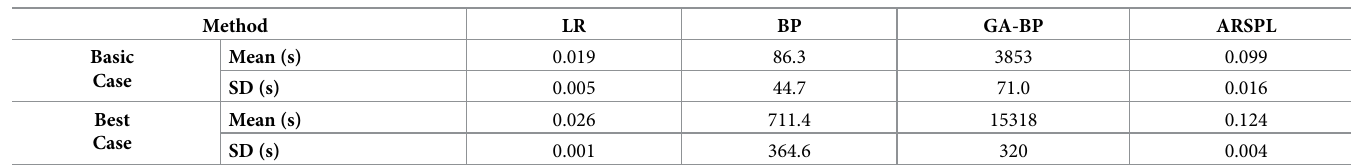
Table 5. Runtime of the four methods.